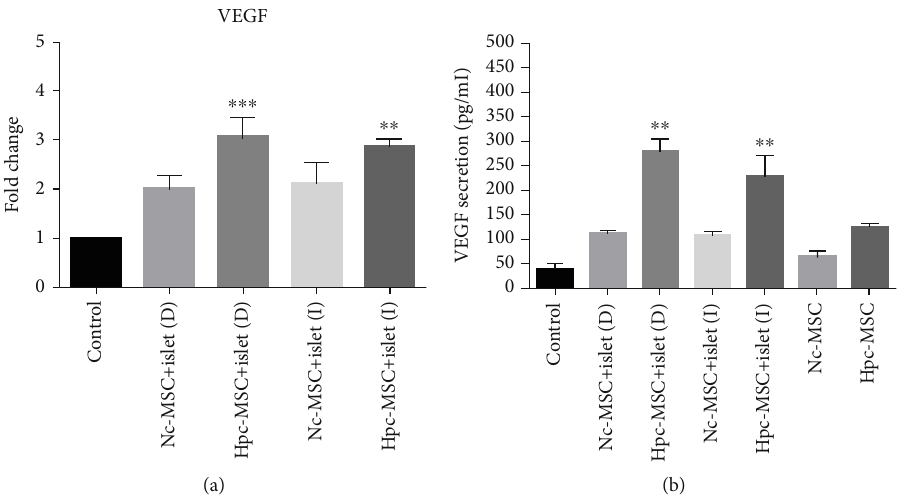
Figure 10: VEGF secretion and mRNA expression in human islets cocultured with Hpc-MSCs and Nc-MSCs. (a) VEGF mRNA expression and (b) VEGF secretion in the islet groups. A comparison was done between the control and each cocultured islets. ∗∗ P < 0 : 01 and ∗∗∗ P < 0 : 001 . Nc-MSCs: normoxia condition mesenchymal stem cells; Hpc-MSCs: hypoxia preconditioning MSCs; D: direct coculture; I: indirect